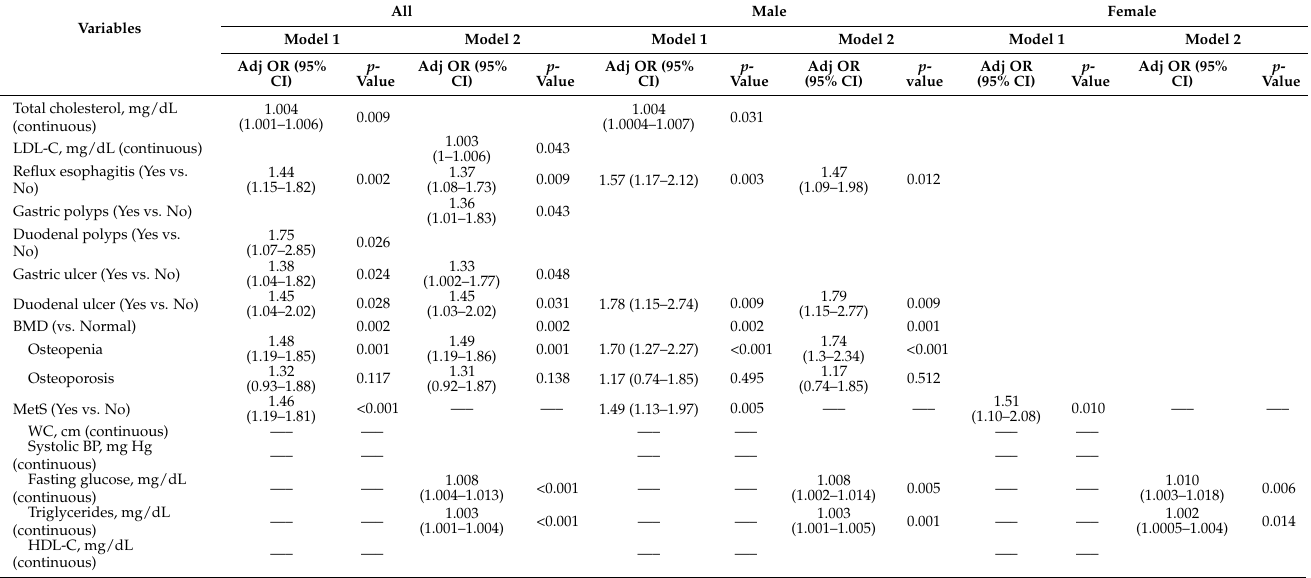
Table 3. Multiple logistic regression analyses of associations between variables and colorectal polyps